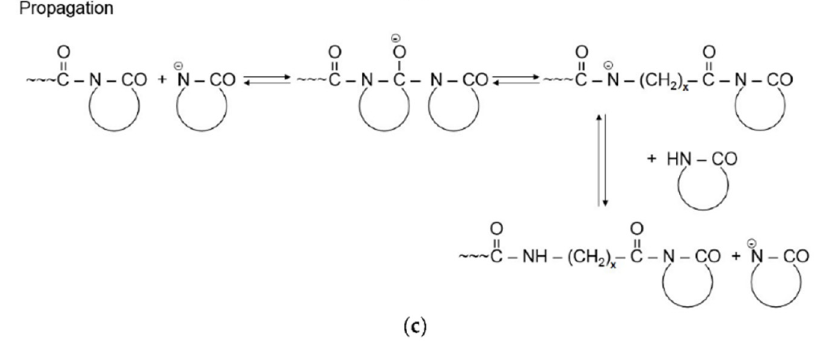
Figure 1. Initiation ( a , b ) and propagation ( c ) of the AROP of lactams, schematically. Note: x = 5 and 11 for CL and LL, respectively. Reprinted from Reference [18], under open-access license.